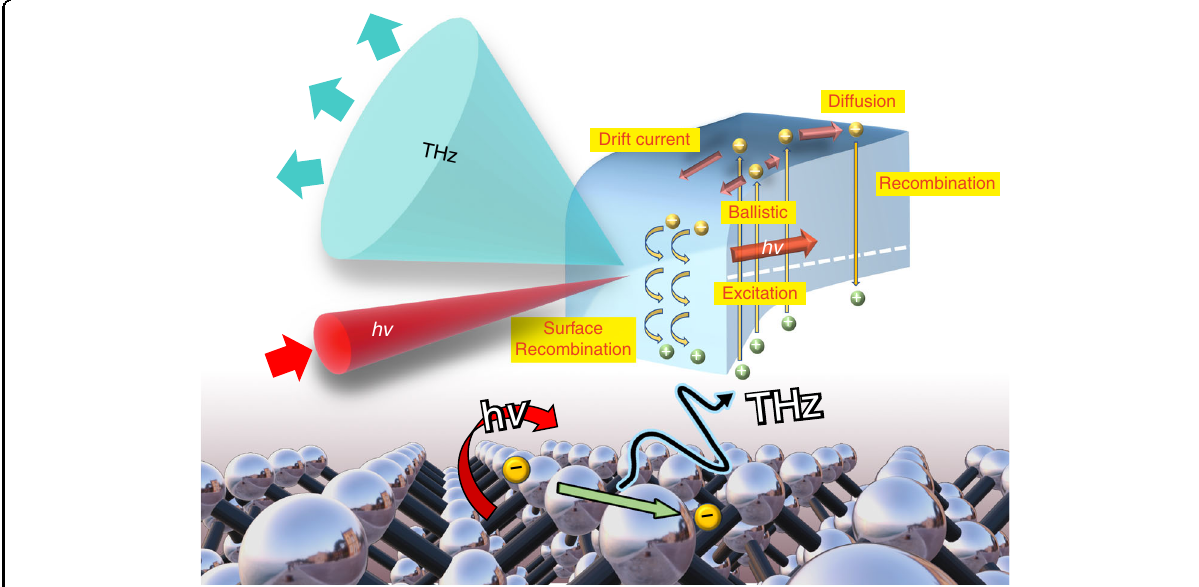
Fig. 1 Illustration of THz emission from a semiconductor surface with laser excitation. The THz emission from the semiconductor is due to the ultrafast charge transport including the drift current, photocarrier diffusion and the